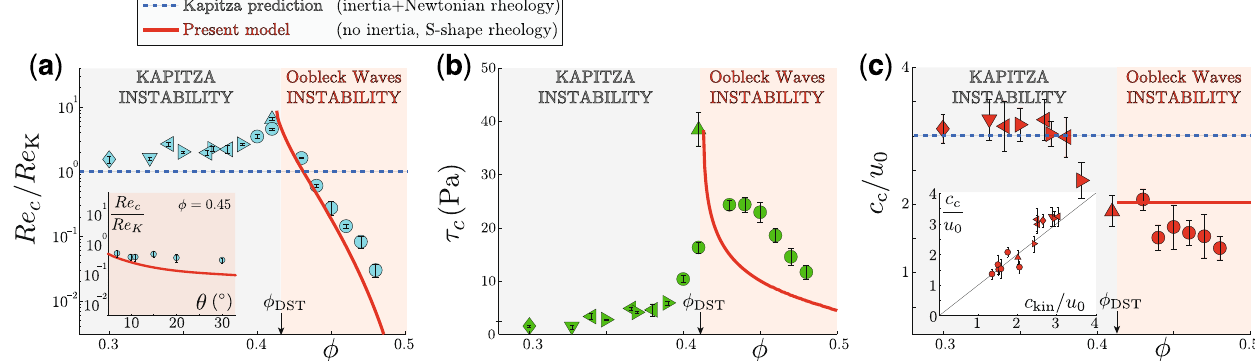
Fig. 2 Onset of instability. a Critical Reynolds number of the instability normalized by the Kapitza threshold Re c / Re k versus volume fraction ϕ . Inset: Re c / Re k versus inclination angle θ for ϕ = 0.45. b Critical shear stress τ c versus ϕ . c Normalized critical wave speed c c / u 0 versus versus ϕ . Inset: c c / u 0 versus speed of the kinematic waves c kin / u 0 , the black line shows that the waves propagate at the speed of the surface kinematic waves. Dashed-blue-line: Kapitza prediction (inertia + Newtonian fl uid). Solid-red-line: prediction of the linear stability analysis ( A ¼ d ~_ γ = d ~ τ fl ow free-surface and the suspension shear-thickening rheology. Different symbols indicate different inclination angles θ : ◇ 2 ∘ , ▿ 3 ∘ , ⊳ 6 ∘ , ⊲ 9 ∘ , ○ 10 ∘ , △ 22 ∘ . The error bars indicate the standard deviation between experimental measurements. Different background colors highlight which instability emerges: Kapitza (gray) or Oobleck waves